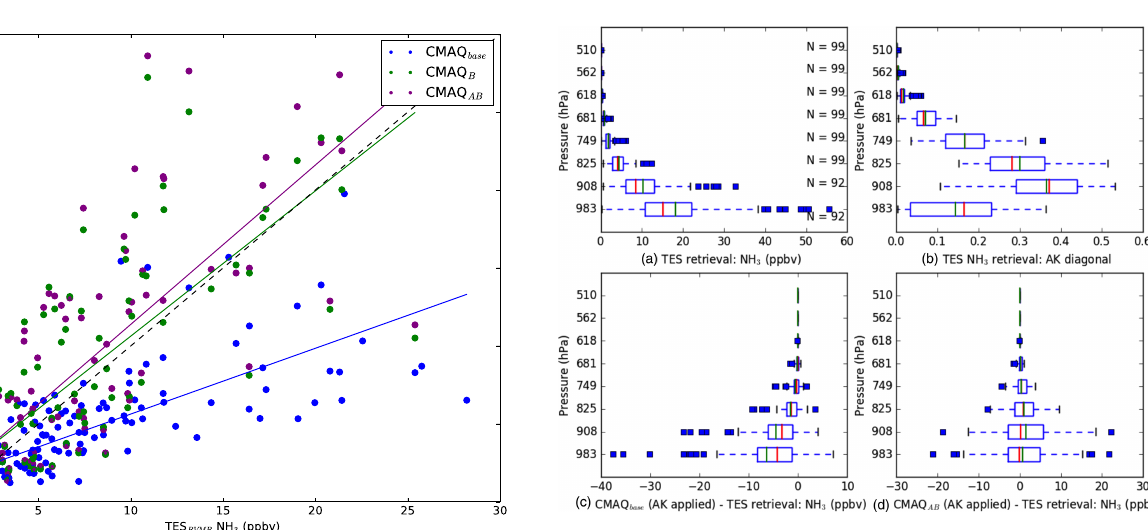
Figure 8. Scatter plot of CMAQ base (blue), CMAQ B (green) and CMAQ AB (purple) versus TES NH 3 representative volume mixing ratios for TES special observation passes (TES RVMR ) during the CalNex campaign, with statistics discussed in Table 3.